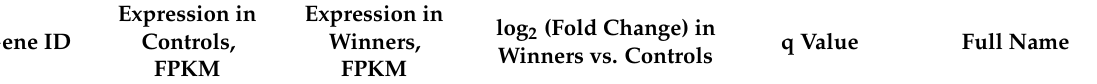
Table 3. Expression of DEGs dealing with the synthesis and transport of serotonin and DEGs encoding neuropeptides CRH and